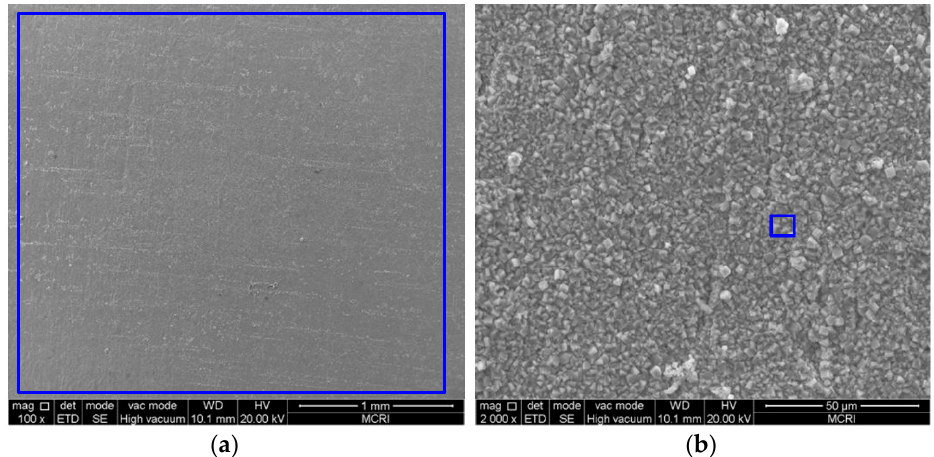
Figure 8. SEM images of the corrosion scales formed on the steel surface in 30% crude oil/brine mixtures at Pco 2 = 9.0 MPa: ( a ) × 100; ( b ) × 2000.